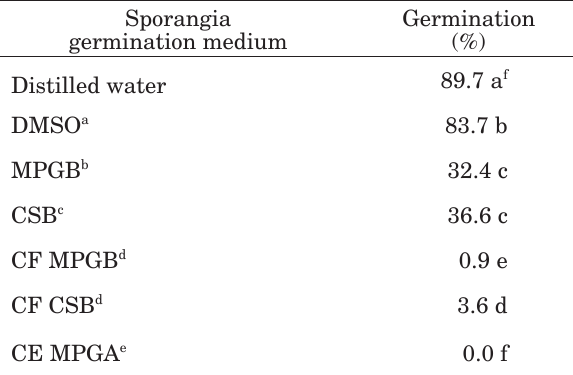
Table 2 . Percent germination of Plasmopara viticola sporangia after 2 h contact with culture fi ltrates (CF crude extract (CE) of Acremonium byssoides strain A21 or with culture